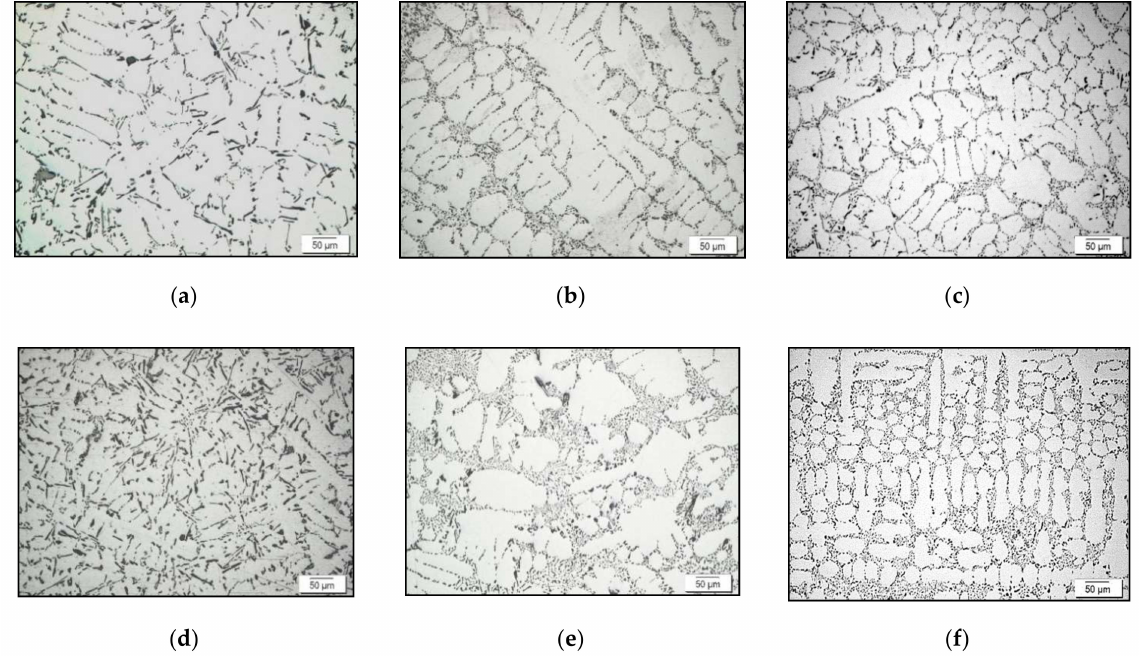
Figure 3. Microstructure of hypoeutectic alloys: ( a ) Alloy 2, untreated; ( b ) Alloy 2, standard flux; ( c ) Alloy 2, complex flux; ( d ) Alloy 3, untreated; ( e ) Alloy 3, standard flux; ( f ) Alloy 3, complex